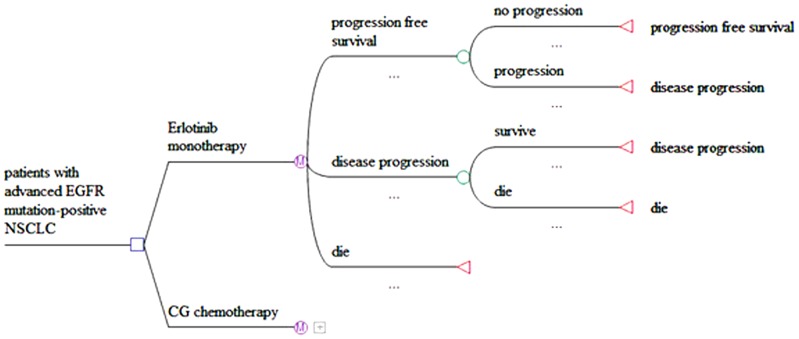
Markov model tree.